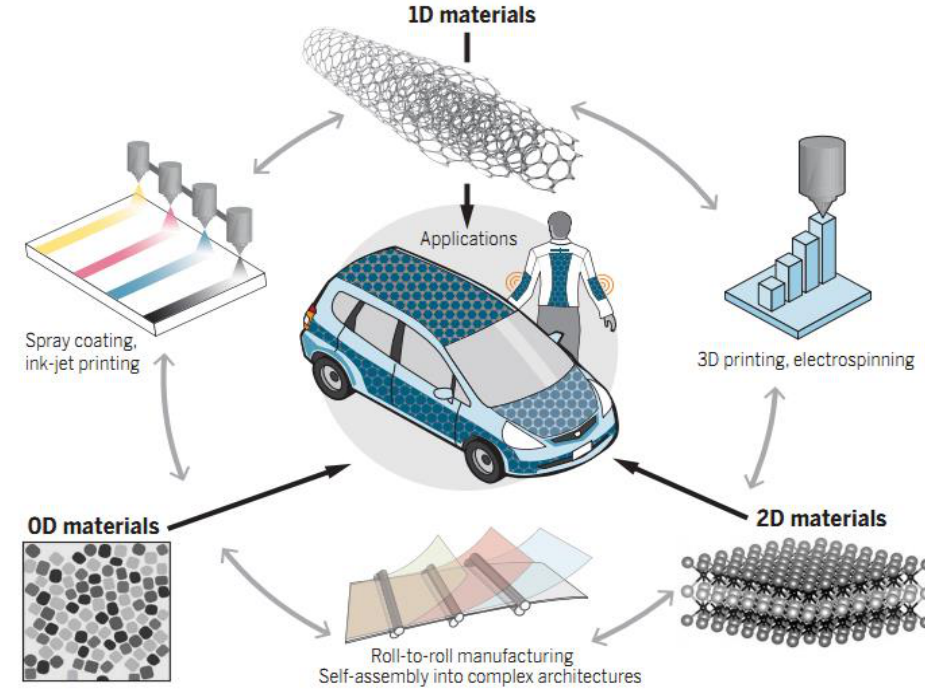
Figure 1. IVA-LD are widely used in energy storage and conversion devices. Reprinted with permission from Ref. [14]. Copyright 2019 American Association for the Science.